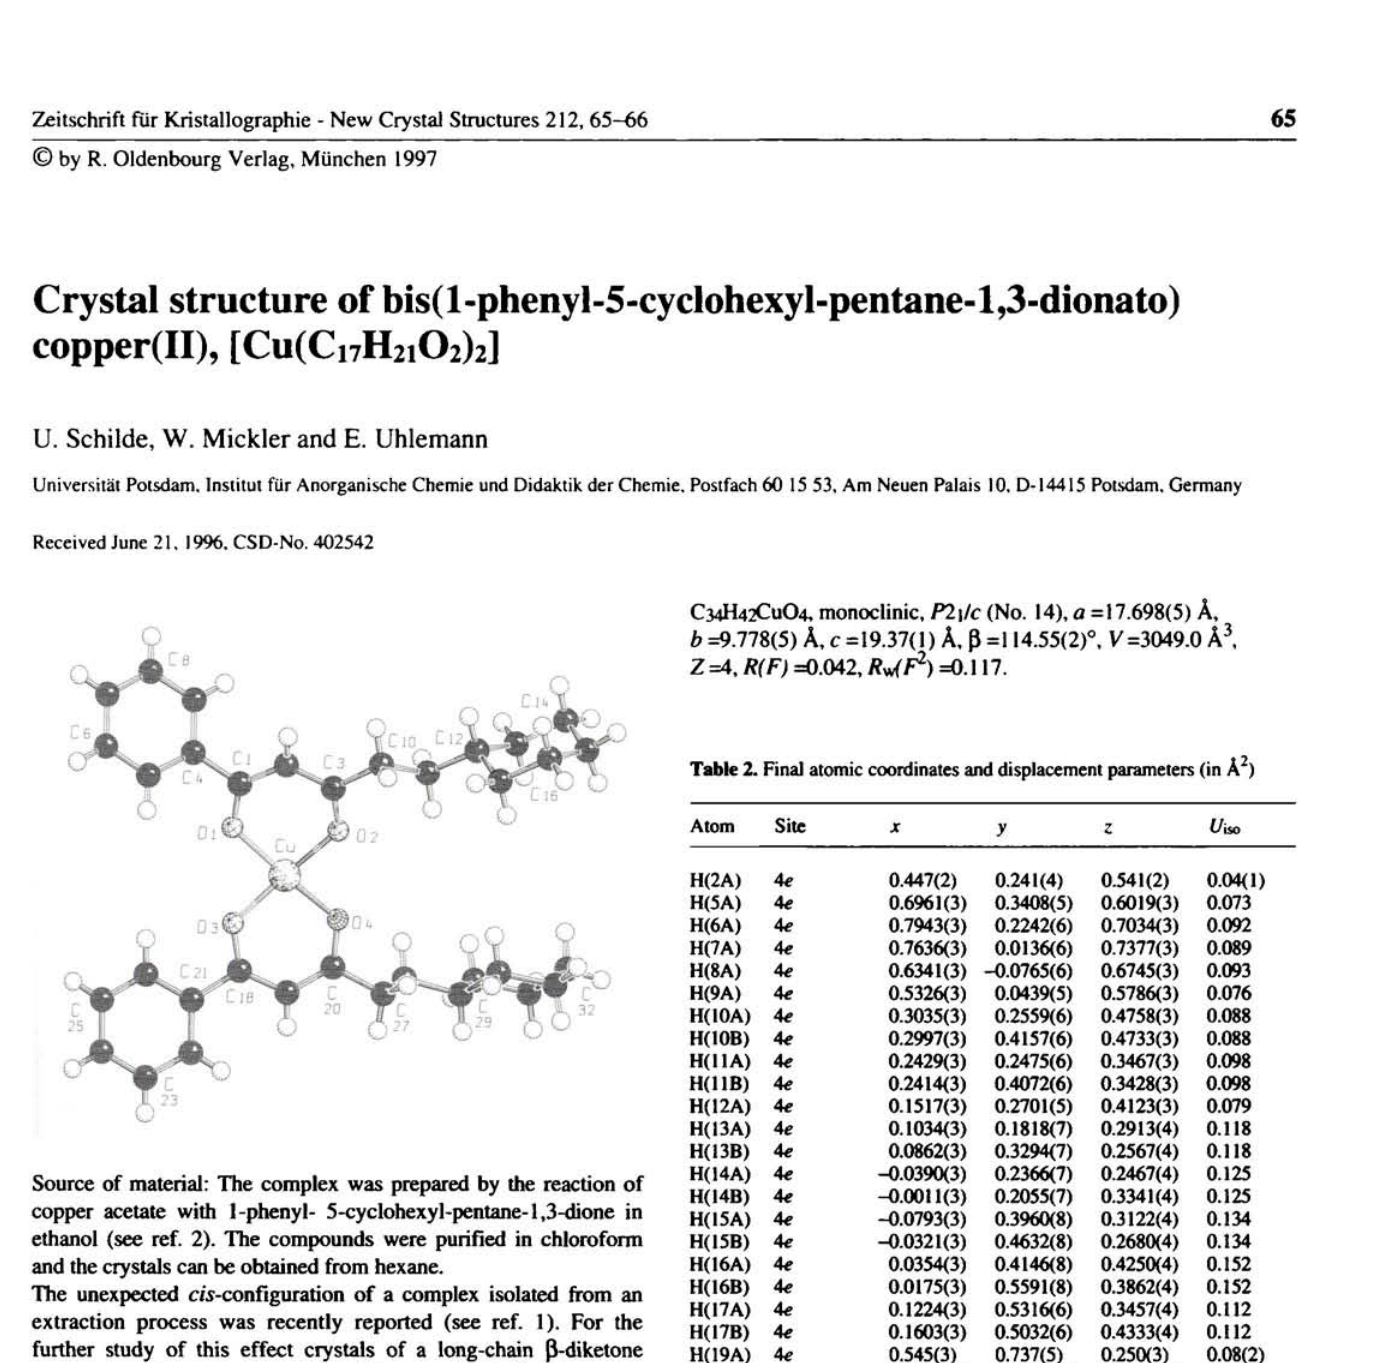
Table 1. Parameters used for the X-ray data collection Crystal: